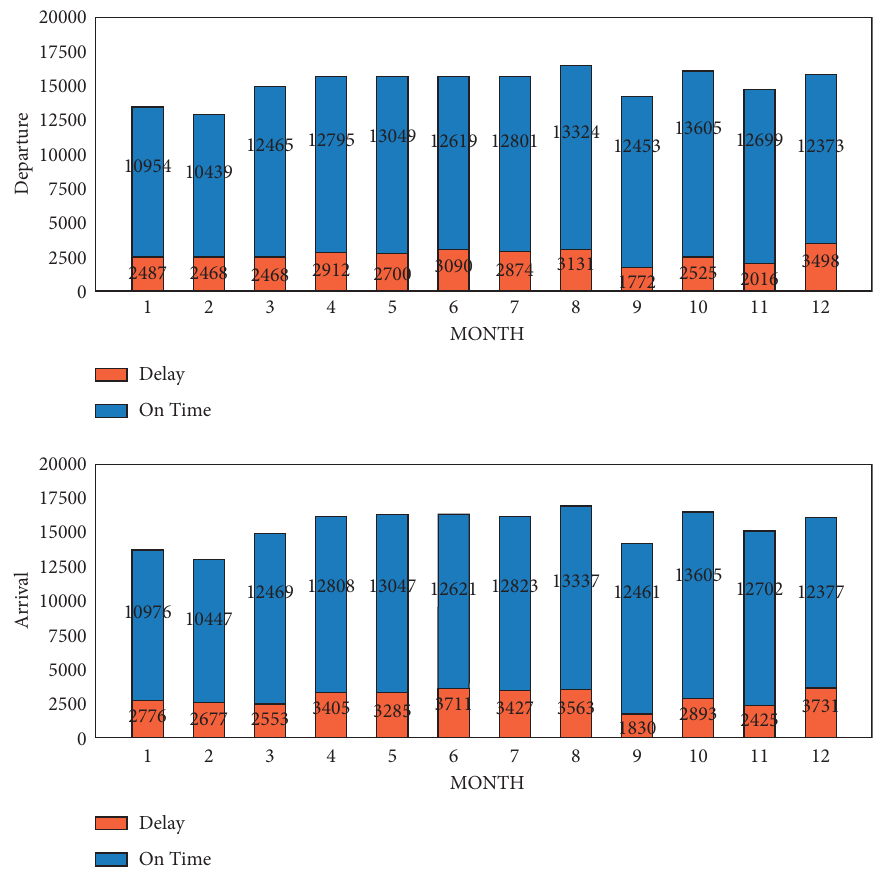
Figure 4: Monthly number of delayed flights and on-time flights. Table 1: The input features and